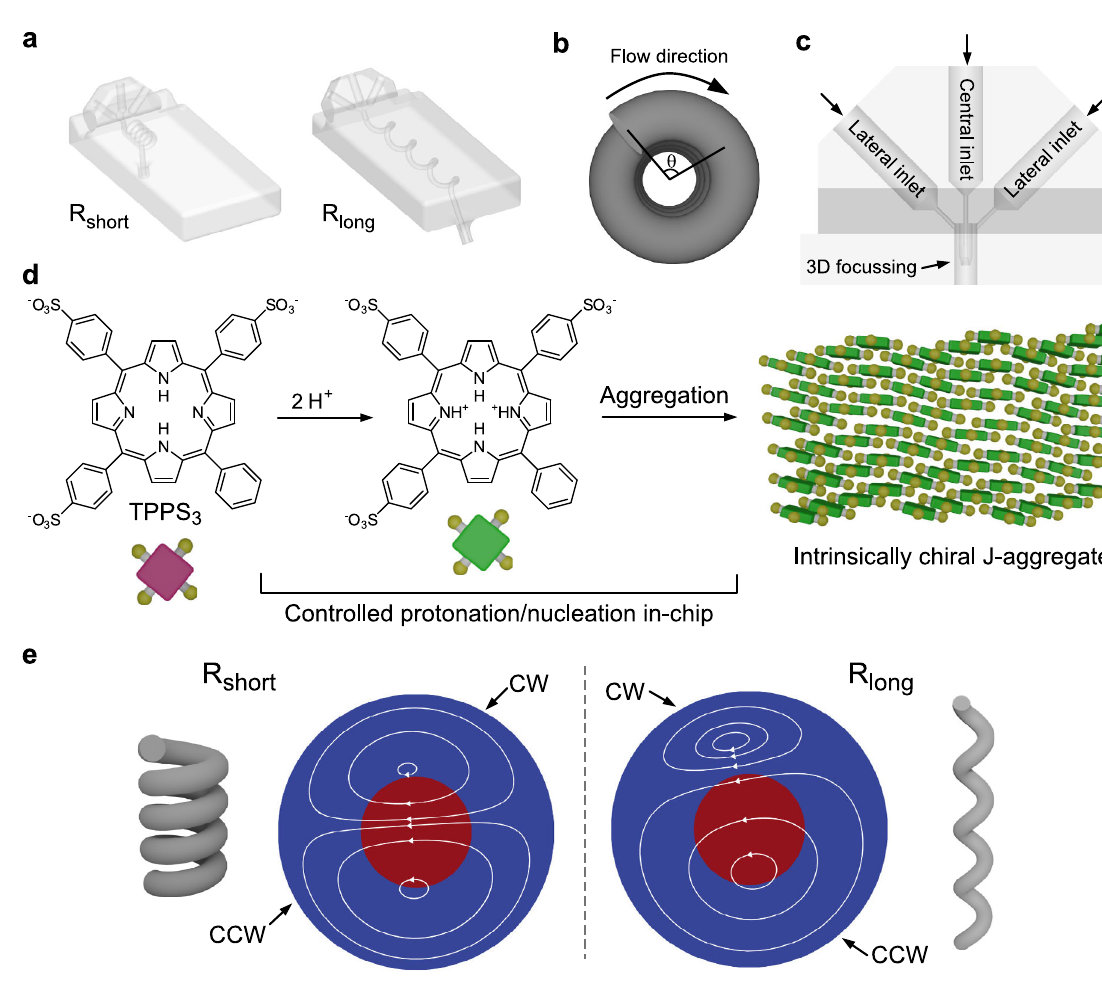
Fig. 1 Representation of the fl uidic devices and supramolecular system used and calculated fl uid trajectories. a Illustrations of R short and R long devices. b De fi nition of the rotational angle θ . c Detail of the inlet portion of fl uidic devices. To achieve a concentric hydrodynamic 3D focussing, a 2 mm long concentric needle was designed to deliver the solution injected through the central inlet at the centre of the main channel, while surrounded by the sheath generated by the solutions fed through the lateral inlets. d Schematic of the protonation-induced aggregation of TPPS 3 to give intrinsically chiral J-aggregates (note: in the cartoon of the porphyrin the yellow balls represent the phenyl rings either bearing or not the sulfonate group). e 2D- representation of trajectories of the secondary fl ow forming inside the R short (left) and R long (right) devices, showing different relative magnitudes of the counter-rotating CW and CCW vortices in short- and long-pitch helices. The porphyrin is injected in the middle of the channel (red colour) surrounded by a sheath of the acid solution (blue region). Boundary conditions: 15 µ M TPPS 3 at the central inlet, 10 mM HCl at the lateral